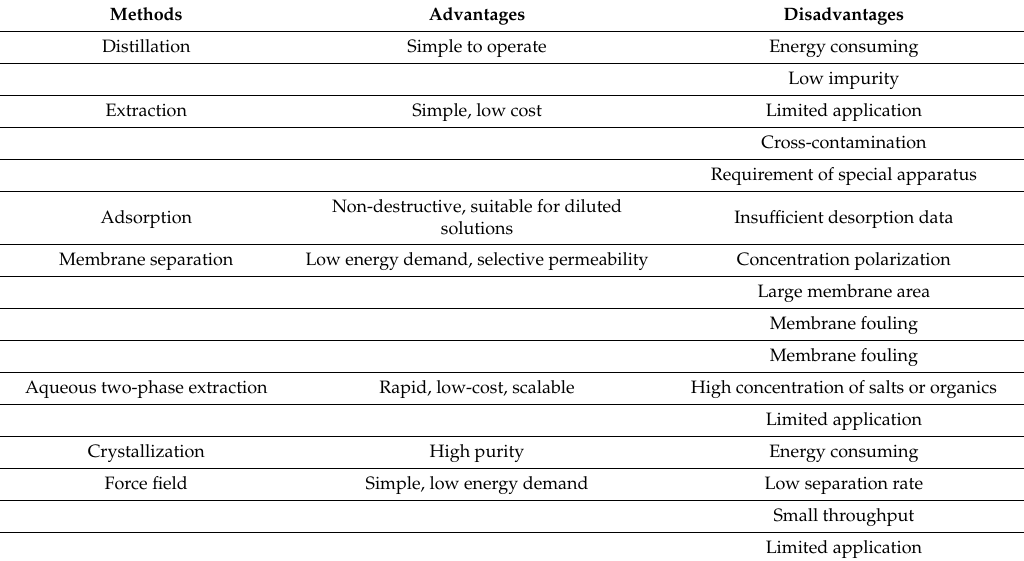
Table 5. Comparison of the advantages and disadvantages for the purification methods in ionic liquids. Adapted with permission from [80], copyright 2018,